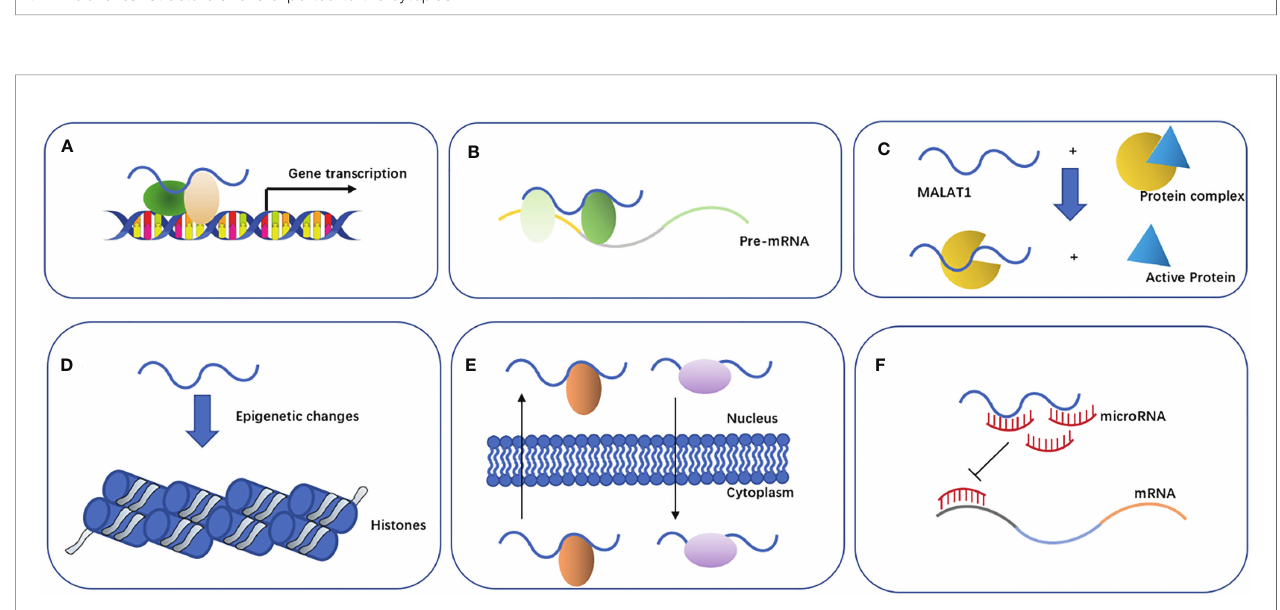
FIGURE 1 | MALAT1 biogenesis. The primary transcript of MALAT1 forms a mature transcript of 7 kb and a small transcript fragment at the 3 ′ end with the cleavage of RNase P. The mature transcript is mainly located in nuclear speckles, and its 3 ′ end is highly conserved and forms a unique triple-helix structure that can protect it from the damage of 3 ′ – 5 ′ exonucleases, which is bene fi cial to the stability of MALAT1 . The small transcript fragment is bound by RNase Z and further cleaved and modi fi ed by the CCA-adding enzyme to produce a 61-nt-long lncRNA called MALAT1 -associated small cytoplasmic RNA (mascRNA), then folds into the tRNA cloverleaf structure and is exported to the cytoplasm.